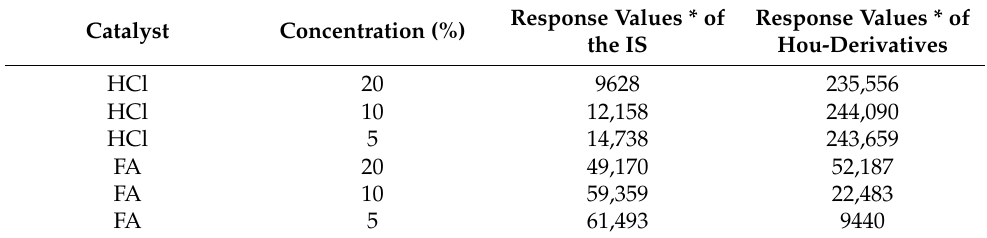
Table 1. Comparison of derivative results of HCl and formic acid (FA) at different concentrations. IS: internal standard. Catalyst Concentration (%) HCl 20 9628